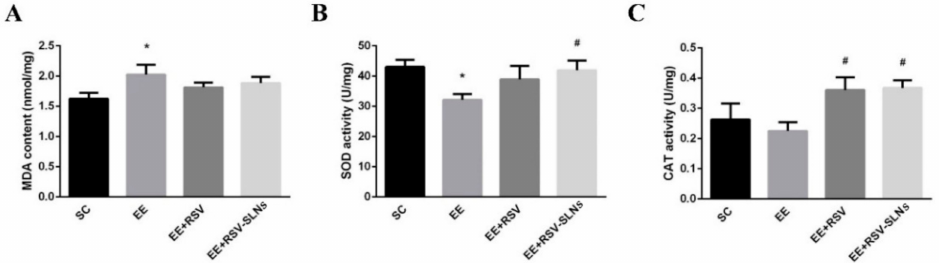
Figure 7. RSV-SLNs attenuates lipid pro-oxidant status during excessive endurance exercise. ( A ) MDA content. Antioxidant enzyme levels of ( B ) SOD and ( C ) CAT in the skeletal muscle from four groups of mice: sedentary control (SC), exhaustive exercise group (EE), exhaustive exercise combined with resveratrol supplementation (EE + RSV), exhaustive exercise combined with RSV-SLNs supplementation (EE + RSV-SLNs). * ( p < 0.05) vs. SC group; # ( p < 0.05) vs. EE group. MDA: malondialdehyde; SOD: superoxide dismutase; CAT: